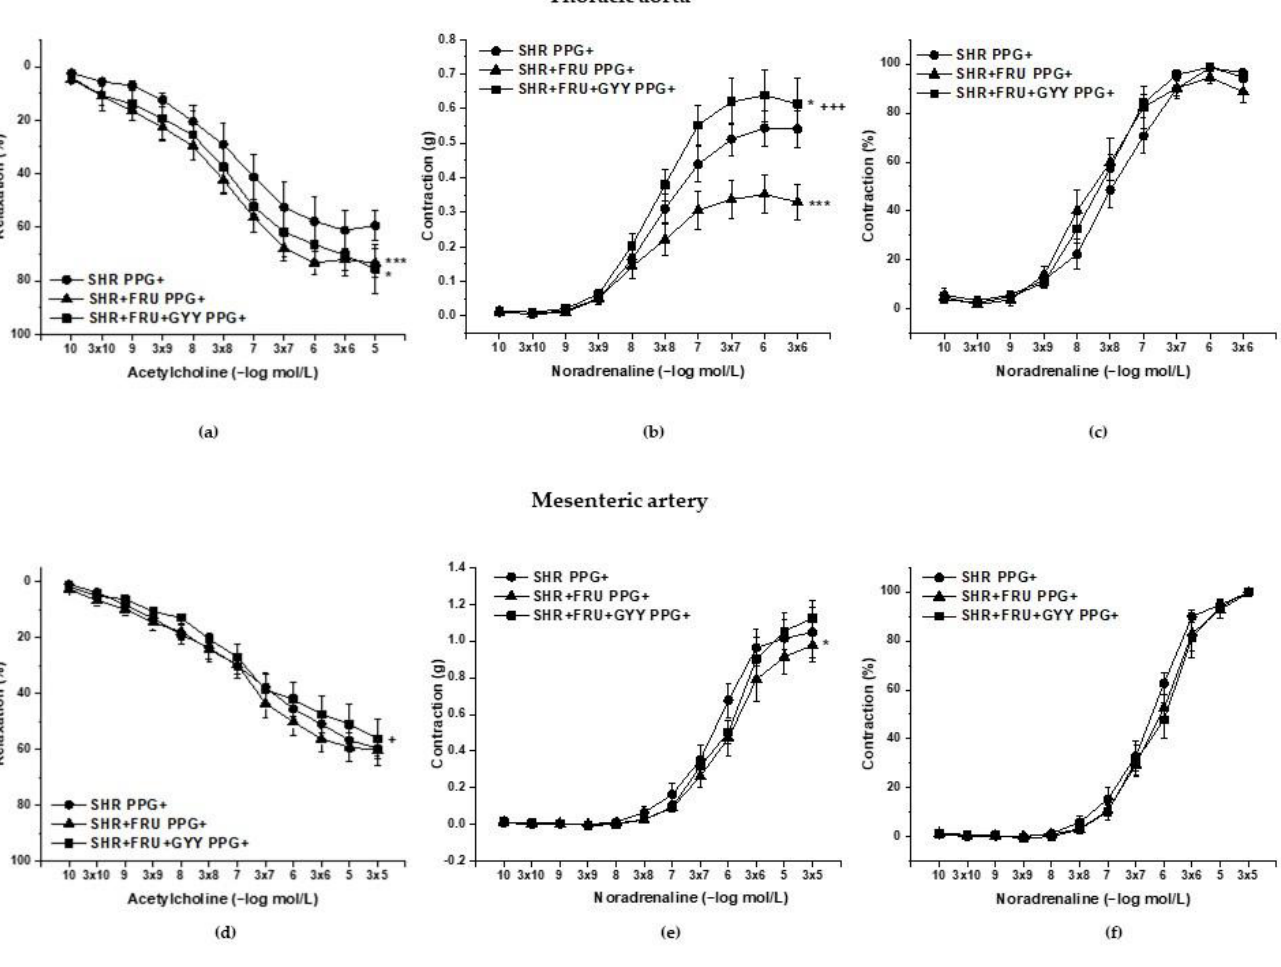
Figure 8. The vasoactive responses of the thoracic aorta ( a – c ) and mesenteric artery ( d – f ) after incu- bation with DL-propargylgycine (PPG). Endothelium-dependent vasorelaxant response of the tho- racic aorta ( a ) and mesenteric artery ( d ). Noradrenaline-induced contractile response of the thoracic aorta ( b ) absolute response, ( c ) percent values of the maximum response), mesenteric artery ( e ) ab- solute response, ( f ) percent values of the maximum response). Arteries were isolated from sponta- neously hypertensive rats (SHR), SHRs treated with fructose (SHR+FRU) and SHRs treated with fructose and GYY-4137 (SHR+FRU+GYY). The results are presented as the mean ± S.E.M. Statistical analysis was performed by two-way ANOVA with a Bonferroni post-hoc test. * p < 0.05 and *** p < 0.001 vs. SHR, + p <0.05 and +++ p < 0.001 vs. SHR+FRU.